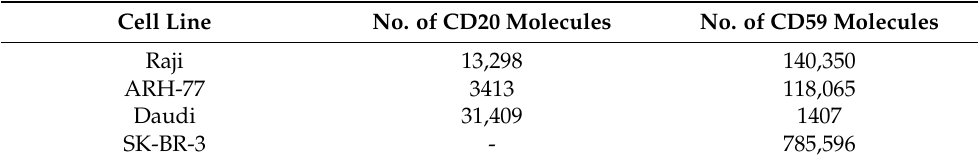
Table 1. Number of CD20 and CD59 molecules per cell of Raji, ARH-77, Daudi, and SK-BR-3 cell lines determined with QIFIKIT ® .